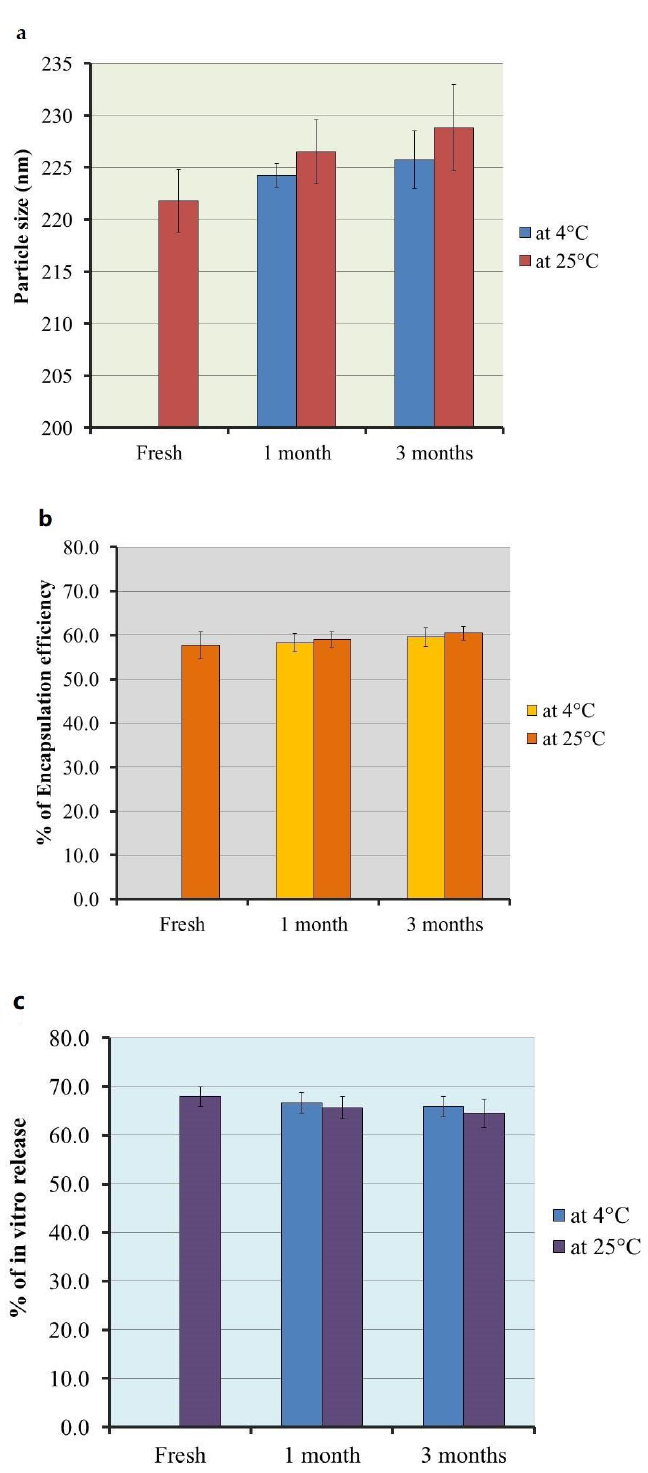
Figure 7. Outline of stability study for optimized PEGylated Brucine liposomal formulation for 1 and 3 months at 4 ◦ C and 25 ◦ C in terms of ( a ) particle size; ( b ) EE and ( c ) in vitro drug release, compared to freshly prepared formulation. Results are expressed as mean ± SD of three